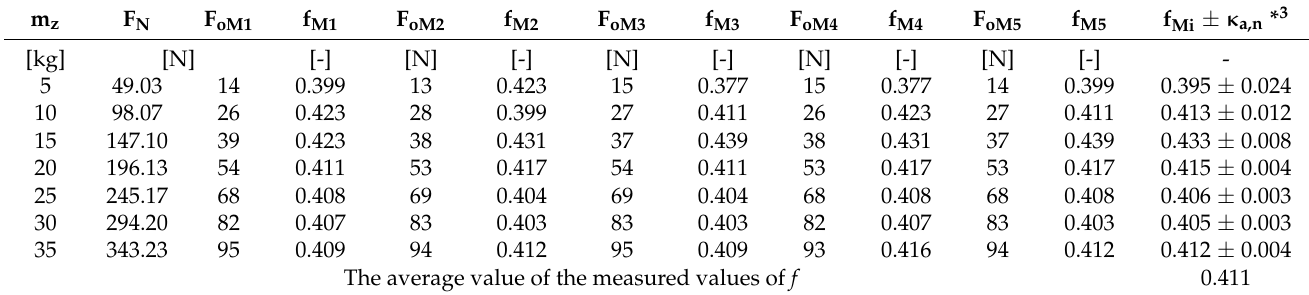
Table 3. Friction coefficient, dry groove, 10 mm diameter cable.